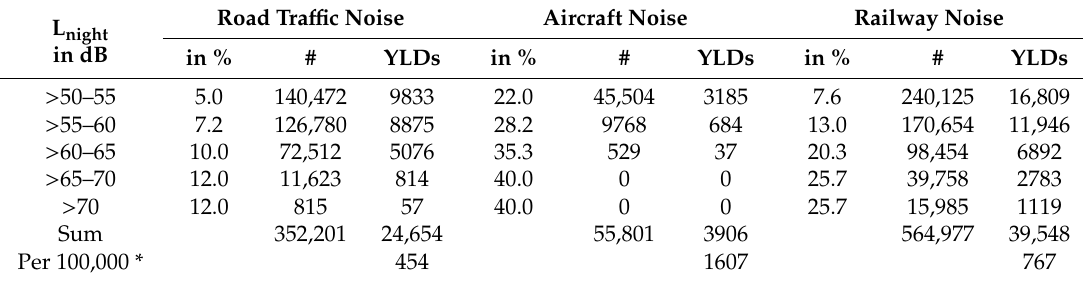
Table 8. Burden of disease due to sleep disturbance attributable to tra ffi c noise in Germany,